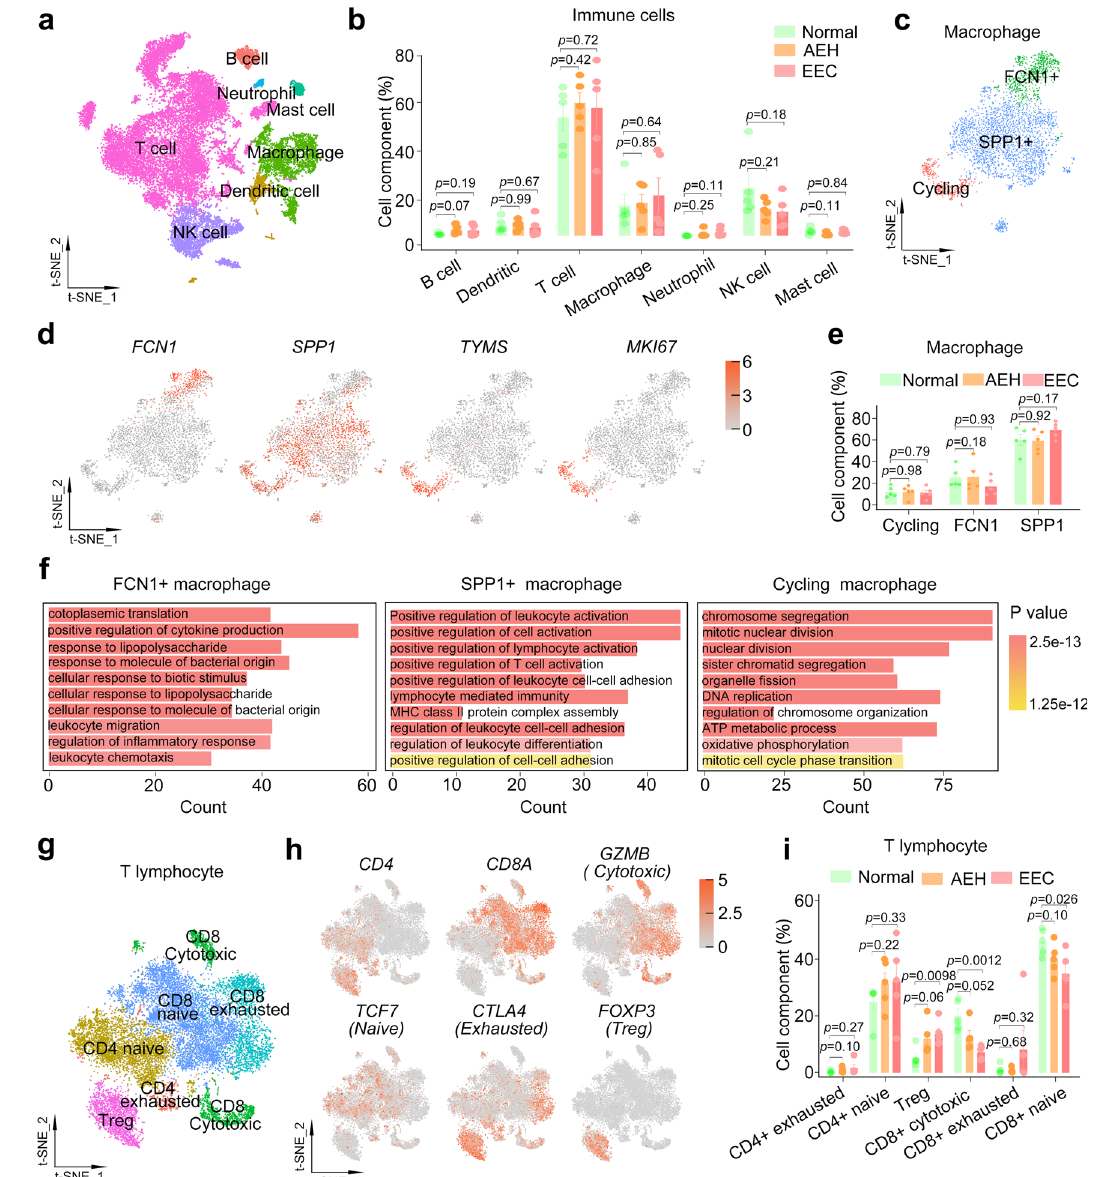
Fig. 7 | Disruption of immune environment from normal to EEC. a t-SNE plot of differentcelltypesofimmunecellsfromnormal,AEHandEEC. b Theproportionof different immune cell types at different stages of endometrial pathology. Data are mean±SEM based on fi ve independent biological replicates. P -value was analyzed bycomparingwithAEHorEECversusnormalgroupandtherewasnosigni fi cance( t test for each group, two-sided, and p -values are denoted above). c t-SNE plot showingmacrophagesubtypes. d